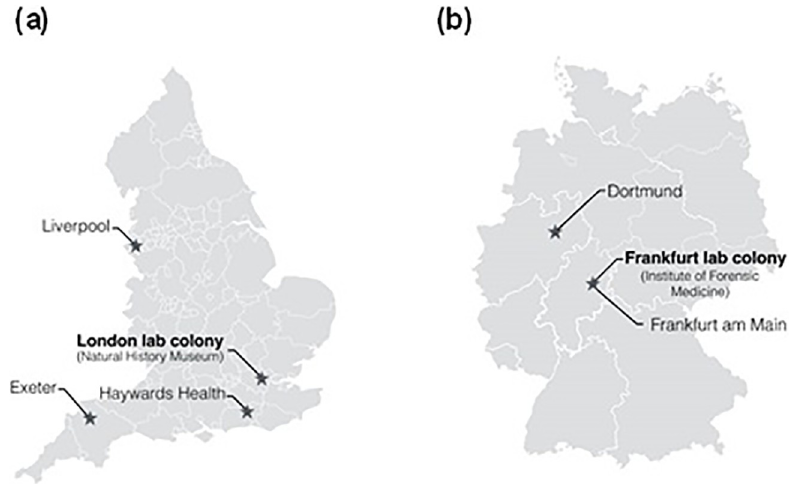
Fig 1. Map of England (a) and Germany (b) showing the sampling areas.